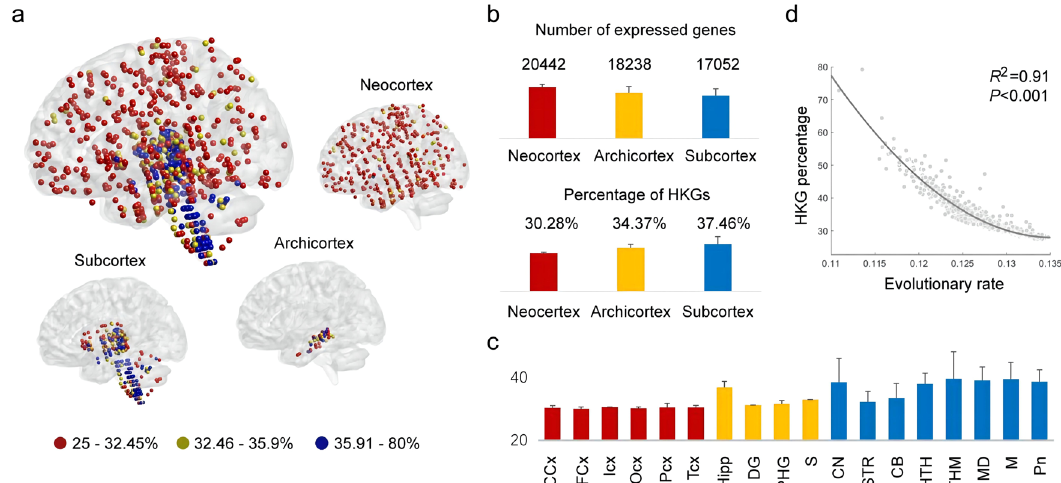
Fig. 1 Gene expression characteristics of human brain samples. a The percentage of HKGs mapped to the brain samples of Brain #1. The proportion of HKG expression to that of other speci fi c genes was considerably higher in the archicortex and subcortex than in the neocortical areas. The HKG percentage cut-off to best distinguish the neocortex and the archicortex and subcortex of Brain #1 was set at 32.45% and 35.90%, respectively. b The mean value and standard deviation of the number of expressed genes and HKG percentage in the neocortex, archicortex and subcortex of Brain #1. c The percentage of HKGs mapped to the main structures of Brain #1. The structures in the neocortex, archicortex and subcortex are marked in red, yellow and blue, respectively. CCx cingulate neocortex, FCx frontal neocortex, Icx insular neocortex, Ocx occipital neocortex, PCx parietal neocortex, TCx temporal neocortex, Hipp hippocampal proper, DG dentate area, PHG parahippocampal gyrus, S subiculum, CN cerebral nuclei, STR striatum, CB cerebellum, HTH hypothalamus, THM thalamus, MD medulla, M midbrain, Pn pons. d The average evolutionary rate of gene expression was negatively correlated with the HKG percentage in the samples of Brain